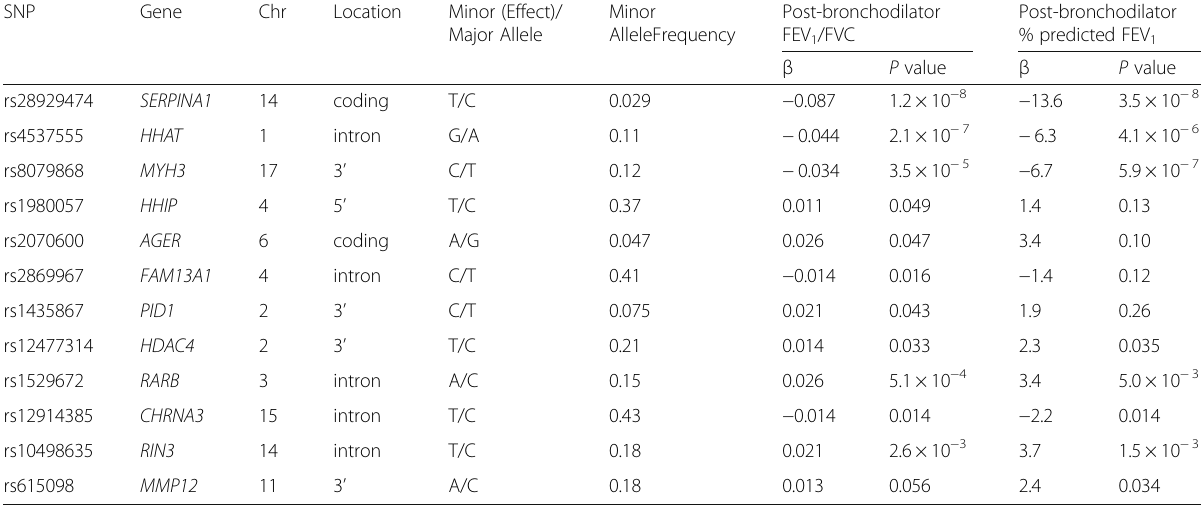
Table 2 Association Results of the Top SNPs ( P < 10 − 6 ) and Candidate Lung Function and COPD SNPs ( P < 0.05) SNP Gene